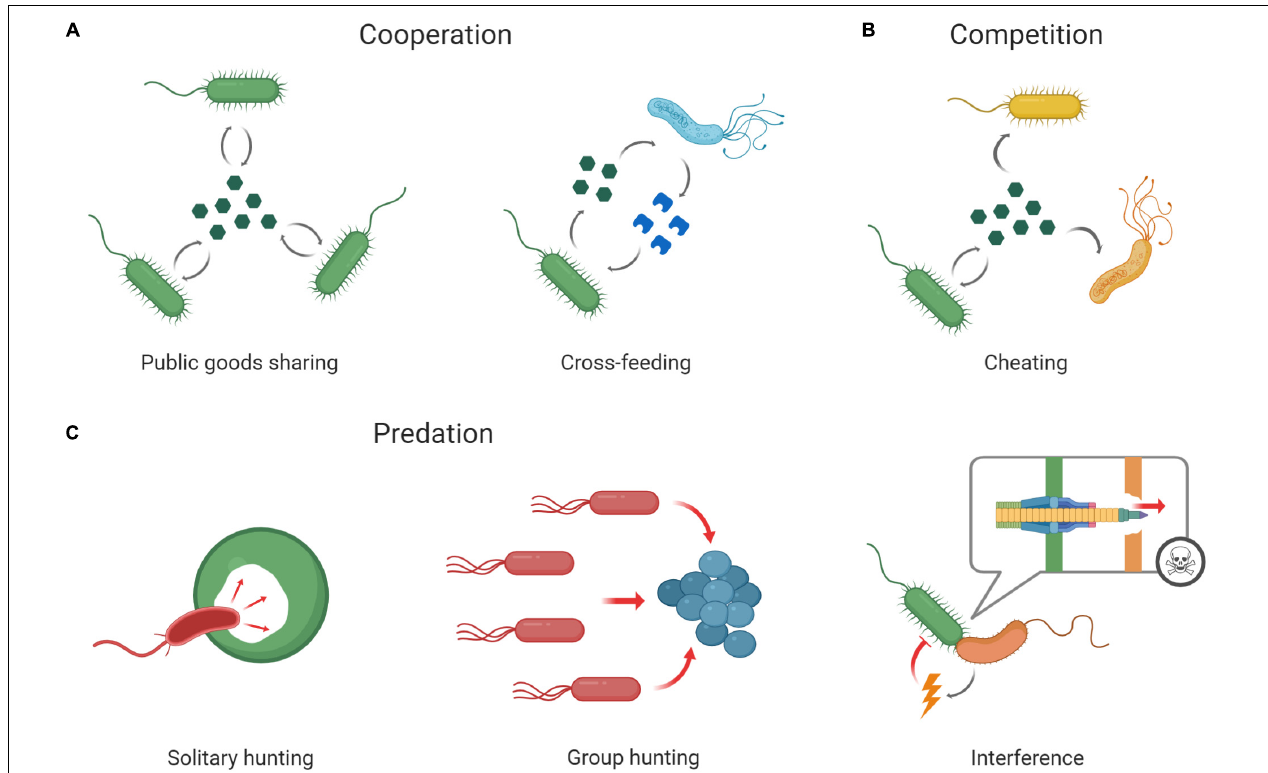
FIGURE 1 | Social interactions among microbes. Microbes frequently interact with clonemates or other microbes of the same or different species (represented by microbes of different colors and shapes, respectively). (A) Cooperation often involves Public goods sharing , where cells secrete a costly secondary metabolite that can be shared among cells. Alternatively, cooperation can involve Cross-feeding , where different genotypes or species exchange different metabolites. (B) Competition is often mediated by Cheating , where individuals capitalize on the public goods produced by others while not contributing (to the same extent) themselves. Other forms of competition involve the direct Interference with competitors, either via the secretion of diffusible toxins (lightning bolt), or via contact-dependent mechanisms (such as type VI secretion systems; speech bubble). (C) Predation frequently occurs in the form of Solitary hunting , and can, for instance, involve single predators that attack and digest their prey from within. Alternatively, it can involve Group hunting , where multiple cells coordinate their